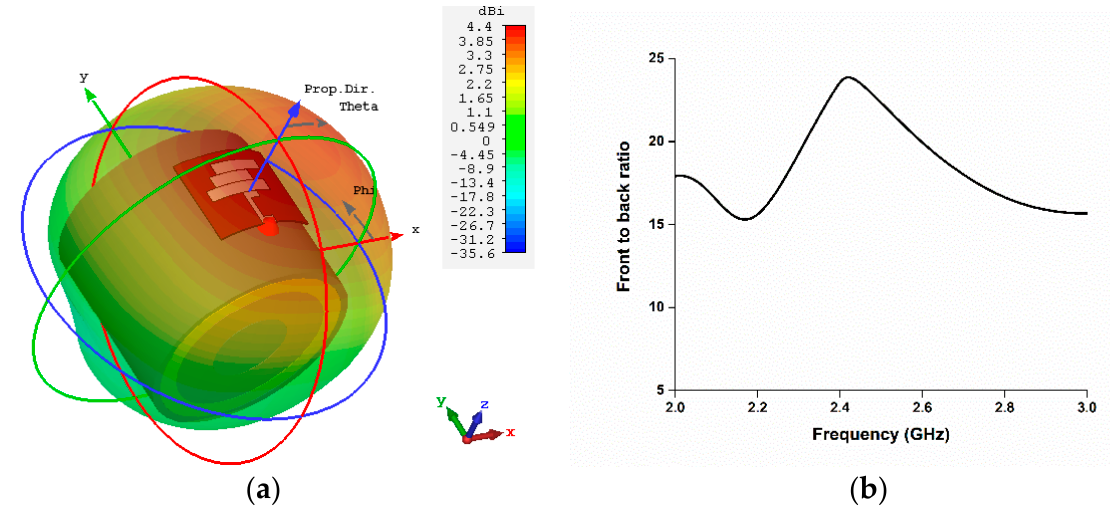
Figure 16. ( a ) Directivity and ( b ) front-to-back ratio of the proposed antenna with human tissue. There were noticeable variations in the reflection coefficient between the measured and simulated results with the homogeneous phantom muscle, as shown in Figure 17. It is clear, however, that the bandwidths are in good agreement. One reason for the slight mismatch might be the difference in the dielectric properties of the computational and realistic phantoms. Some other factors could increase the losses of the coupling medium, and the measurement tolerance could impact the results. The radiation patterns of the antenna with the muscle are shown in Figure 18b. The radiation patterns with the phantom muscle remain stable to a satisfactory degree. The overall performance of the antenna seems to be in good harmony when in free space and with the phantom muscle.